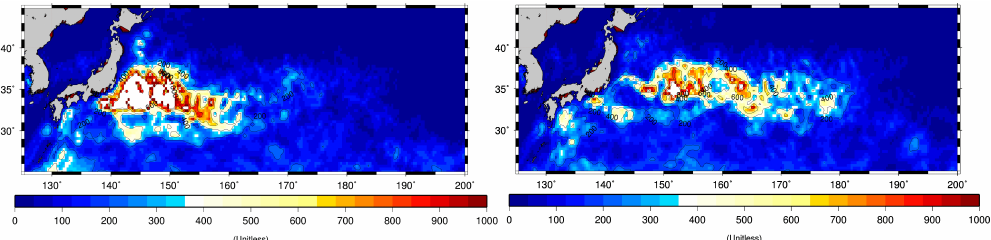
Fig. 4. Yearly averaged high-frequency EKE in the KE region during the 1997 contracted state (left panel) and the 2003 elongated state (right